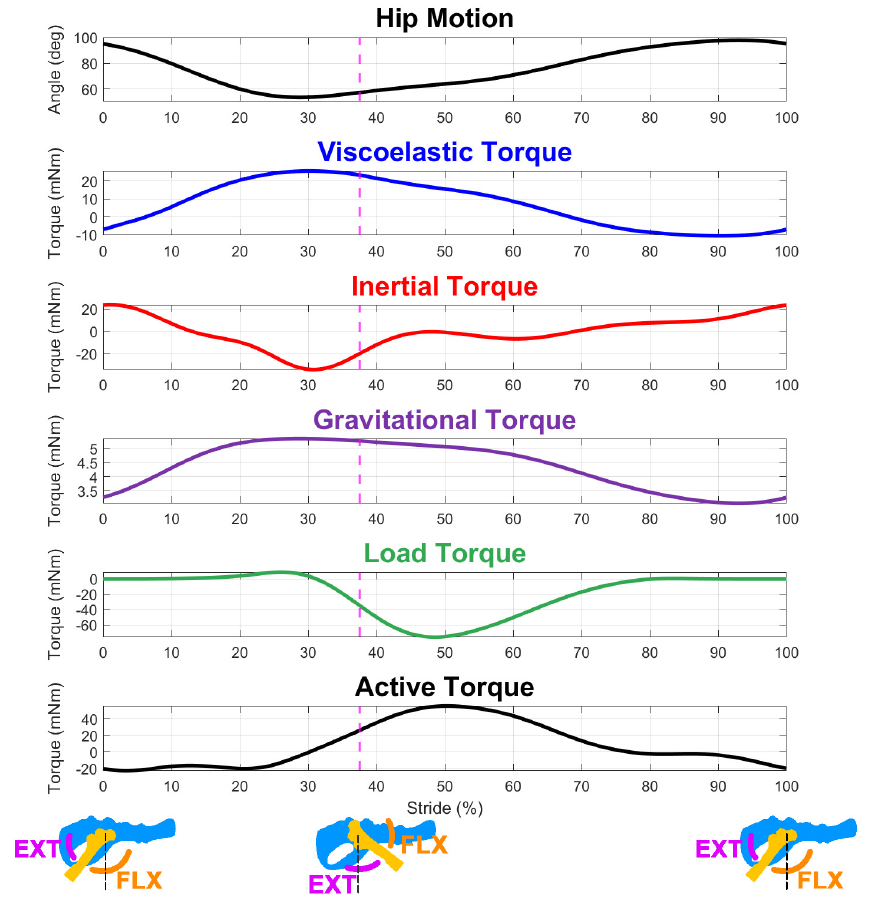
Figure 3. The constituent torques necessary for active muscle coordination are calculated for each joint from the walking model. The dashed line indicates the end of swing and the start of stance; schematics under the data panels show the relative positions of the limb and the extensor/flexor activations associated with its movement. Constituent torques include those required to overcome passive viscoelastic torque due to muscle stretching, inertial torque from moving limb segment masses, gravitational torque from the weight of the limb, and simulated load torque during stance. Active muscle torque counteracts passive hindlimb torques to generate forward motion. The relative contributions of each constituent torque vary depending on the scale of the animals, as indicated by the independent scales of each waveform.